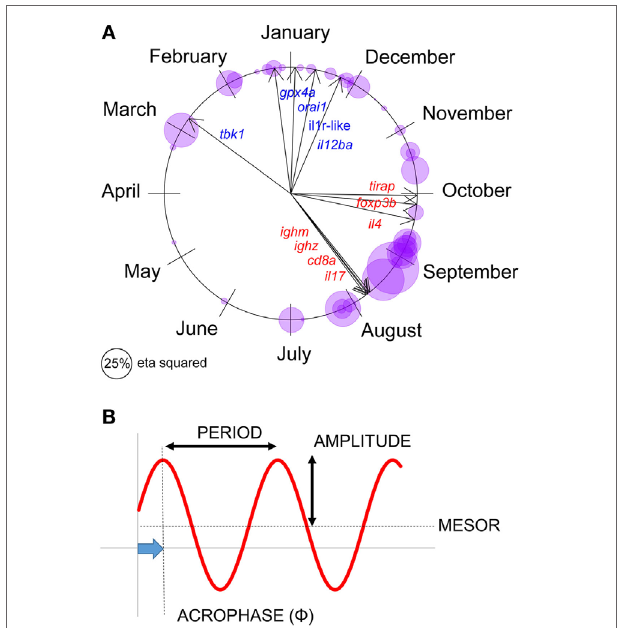
FigUre 2 | Seasonal expression responses for individual immune- associated genes in wild sticklebacks. (a) Circular plot of the acrophase of maximum expression in individual genes, for each site × year combination; bubbles represent individual observations and are sized according to the seasonal (sinusoid) effect size in cosinor models (classical η 2 ). Arrows represent the acrophase mean direction for each gene across the two sites and years. (B) Parameters describing a seasonal sinusoid.